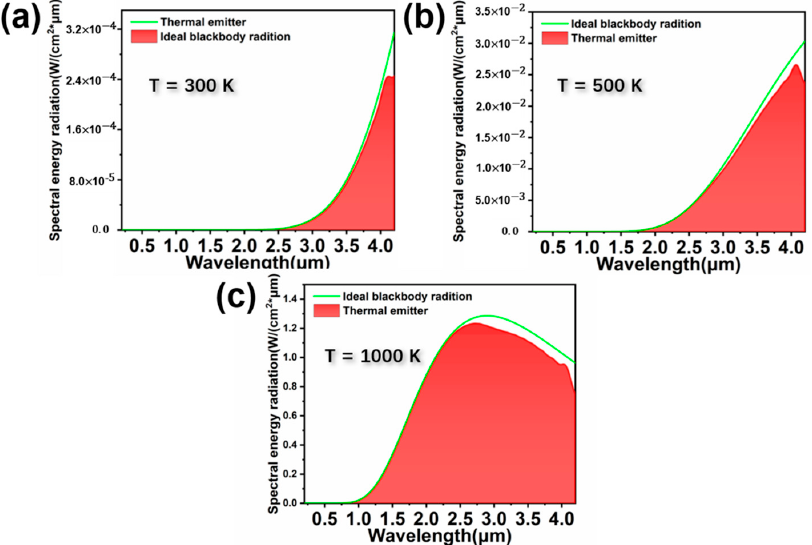
Figure 11. ( a – c ) are the heat radiation effect diagrams of the structure at 300 K, 500 K and 1500 K, respectively.